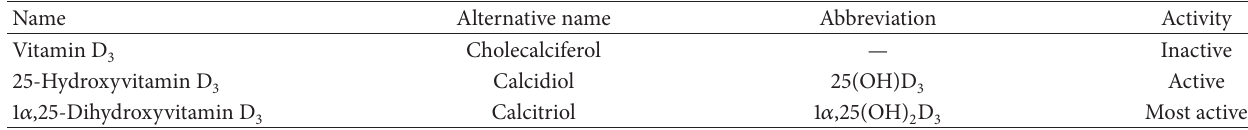
Table 1: Names and abbreviations of the forms of vitamin D